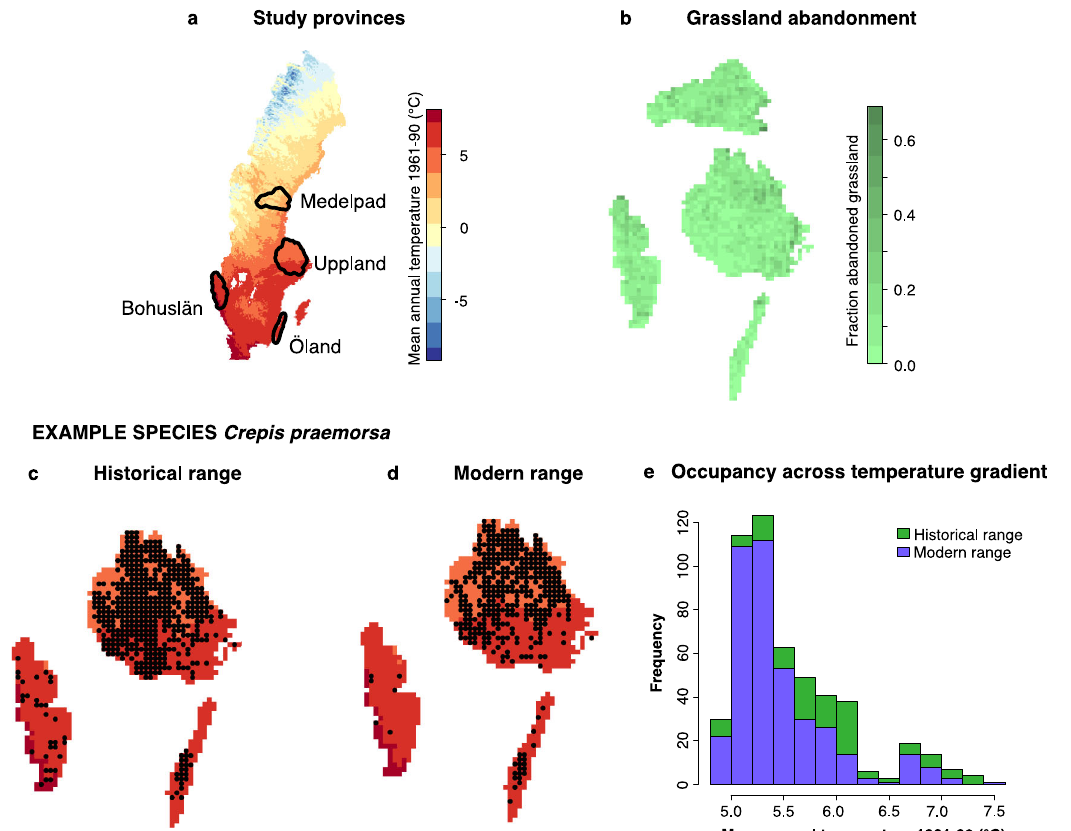
Fig. 1 | Study system. a Data in the study are taken from four Swedish provinces along a climate gradient. b Since the 1940s – 60s, large amounts of grassland have been abandoned in all provinces, with high fractions of 5 × 5km grid cells now coveredwithforestthatwasonpreviouslyopenland.Observationdataweretaken fromhistoricalandmodernplantatlases,translatedintooccupancyin5×5kmgrid